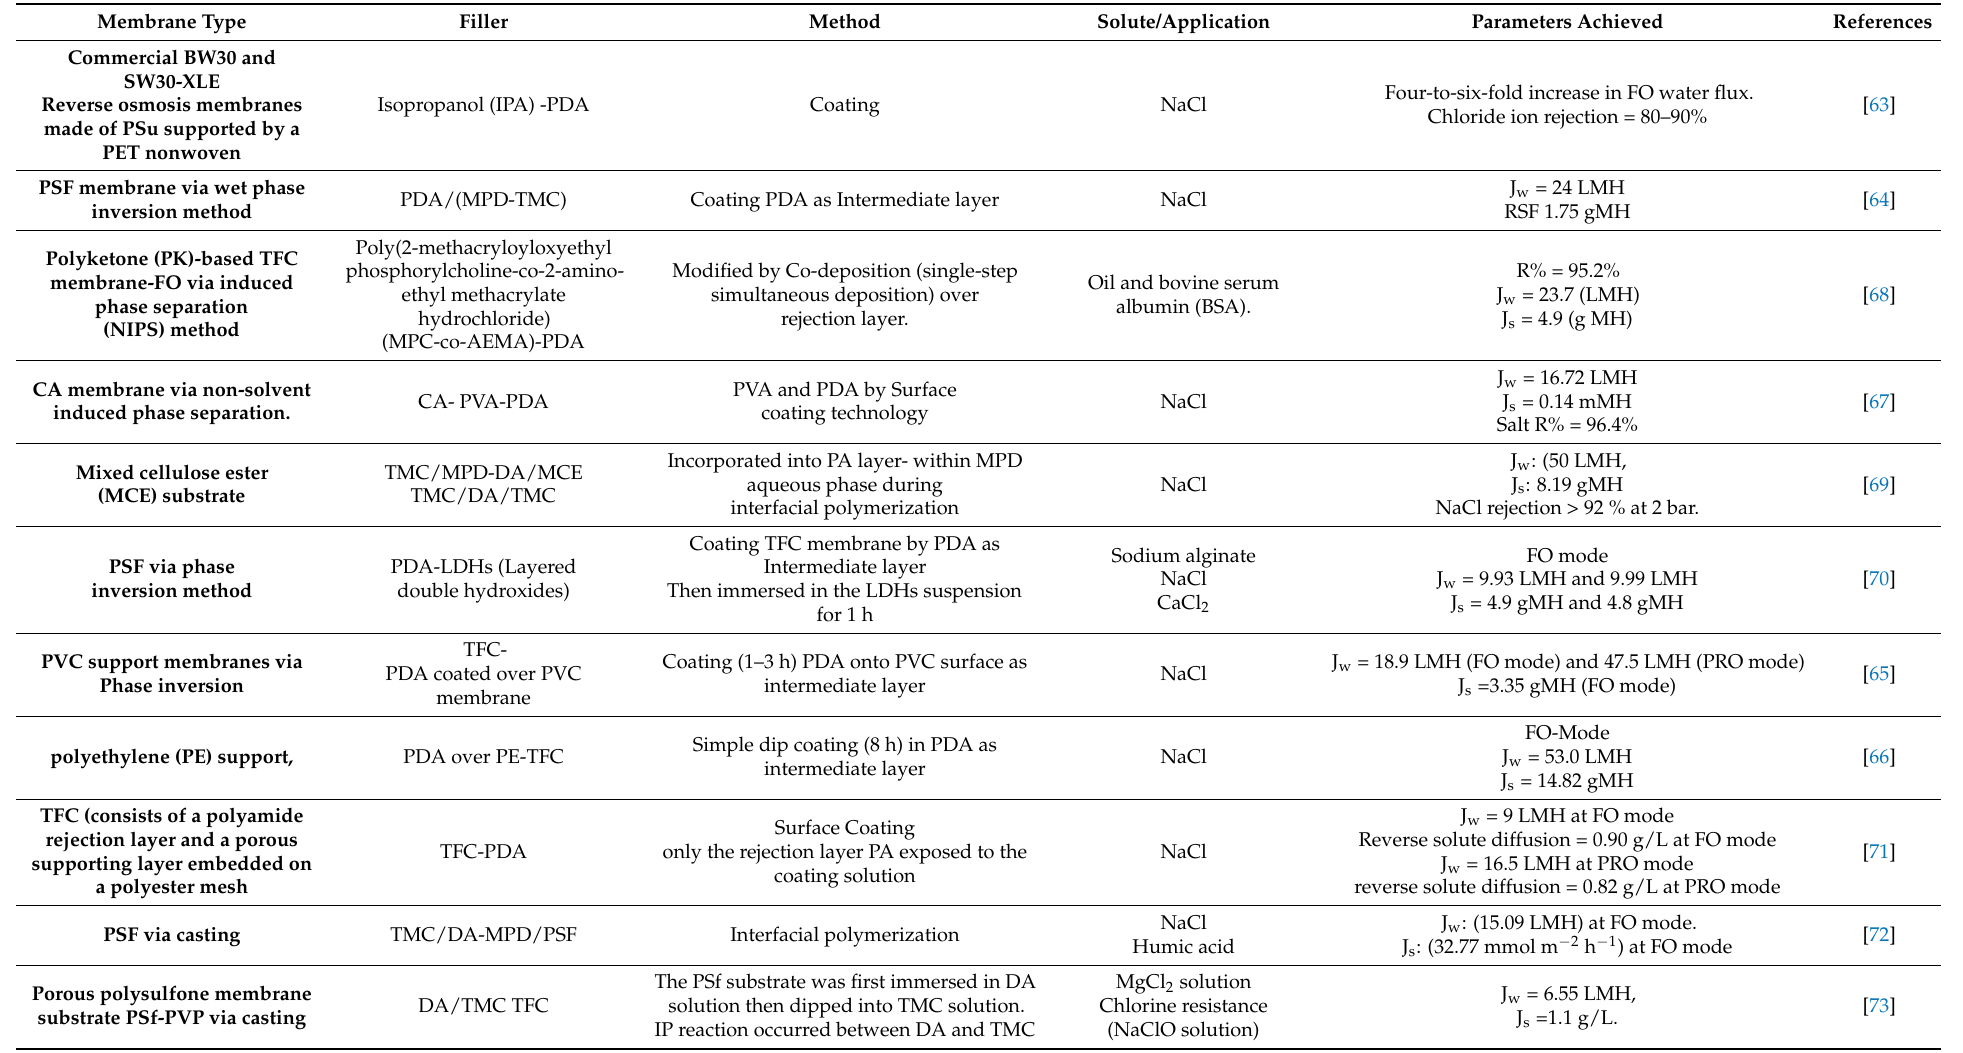
Table 3. Studies of FO membranes modification by PDA freestanding and PDA with NPs-based